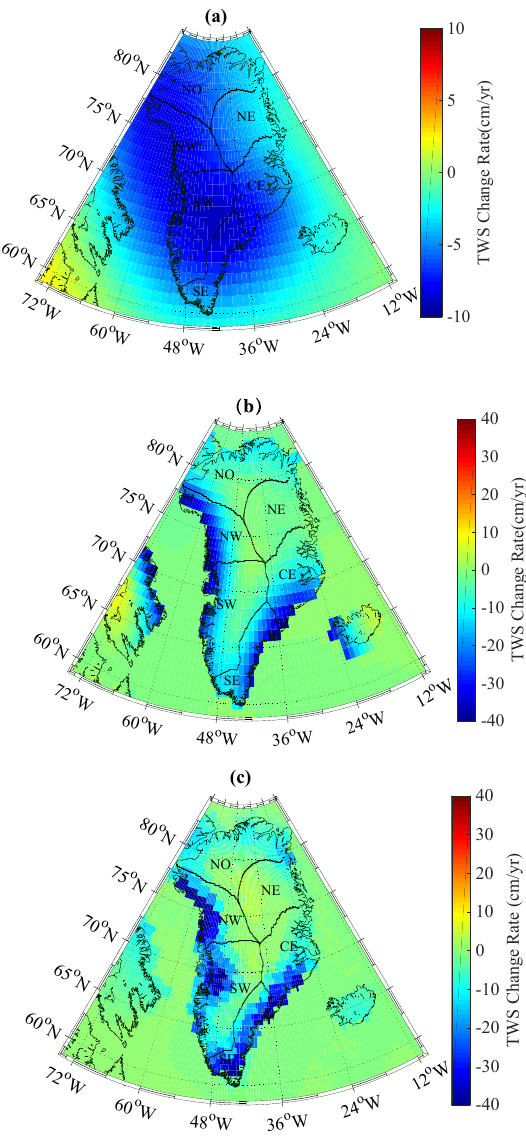
Figure 4. Mass change rates (in terms of equivalent water thickness) between April 2002 and June 2017: ( a ) GRACE apparent mass rate before correcting for the ocean-land leakage effect, ( b ) the forward modeled mass rate after correcting for the ocean-land leakage effect, and ( c ) the CSR RL05 GRACE mascon solution.